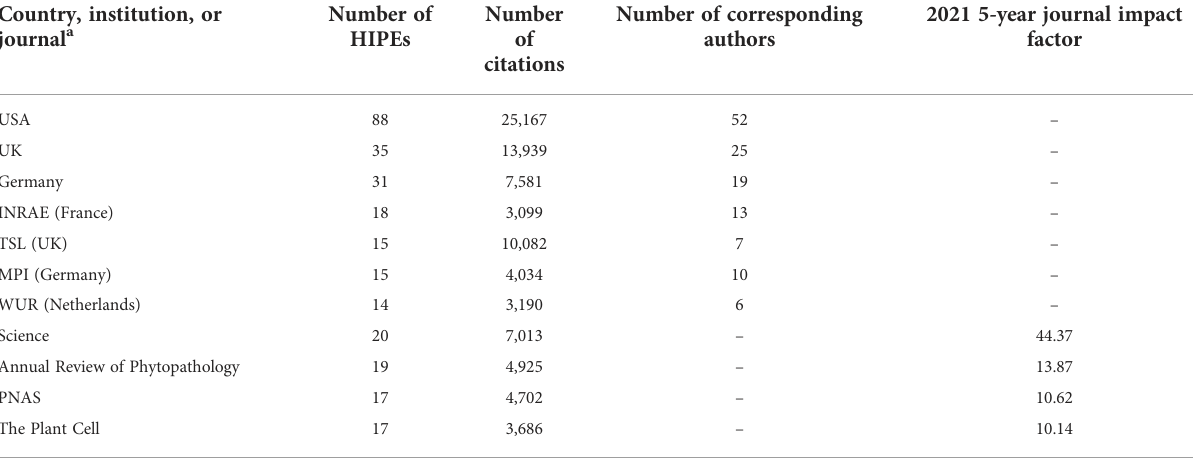
TABLE 1 Top countries, institutions, and journals that publish the most HIPEs. Country, institution, or journal